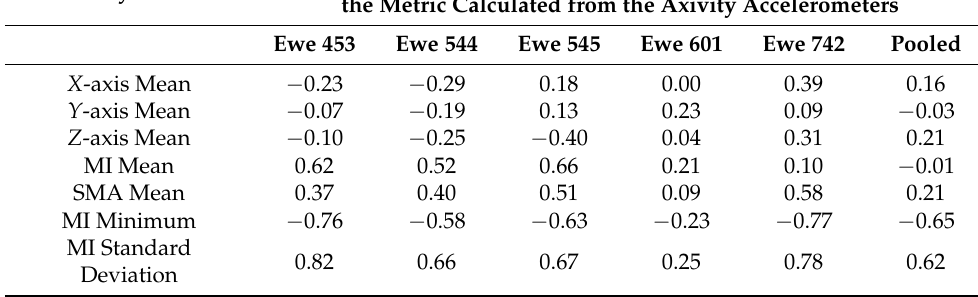
Table 2. Correlation coefficients between the hourly average of the HerdDogg accelerometer index and hourly means of metrics calculated from an Axivity accelerometer attached to the opposite ear on the same ewe. Correlation coefficients were calculated from 8 d of data on five ewes, both individually and